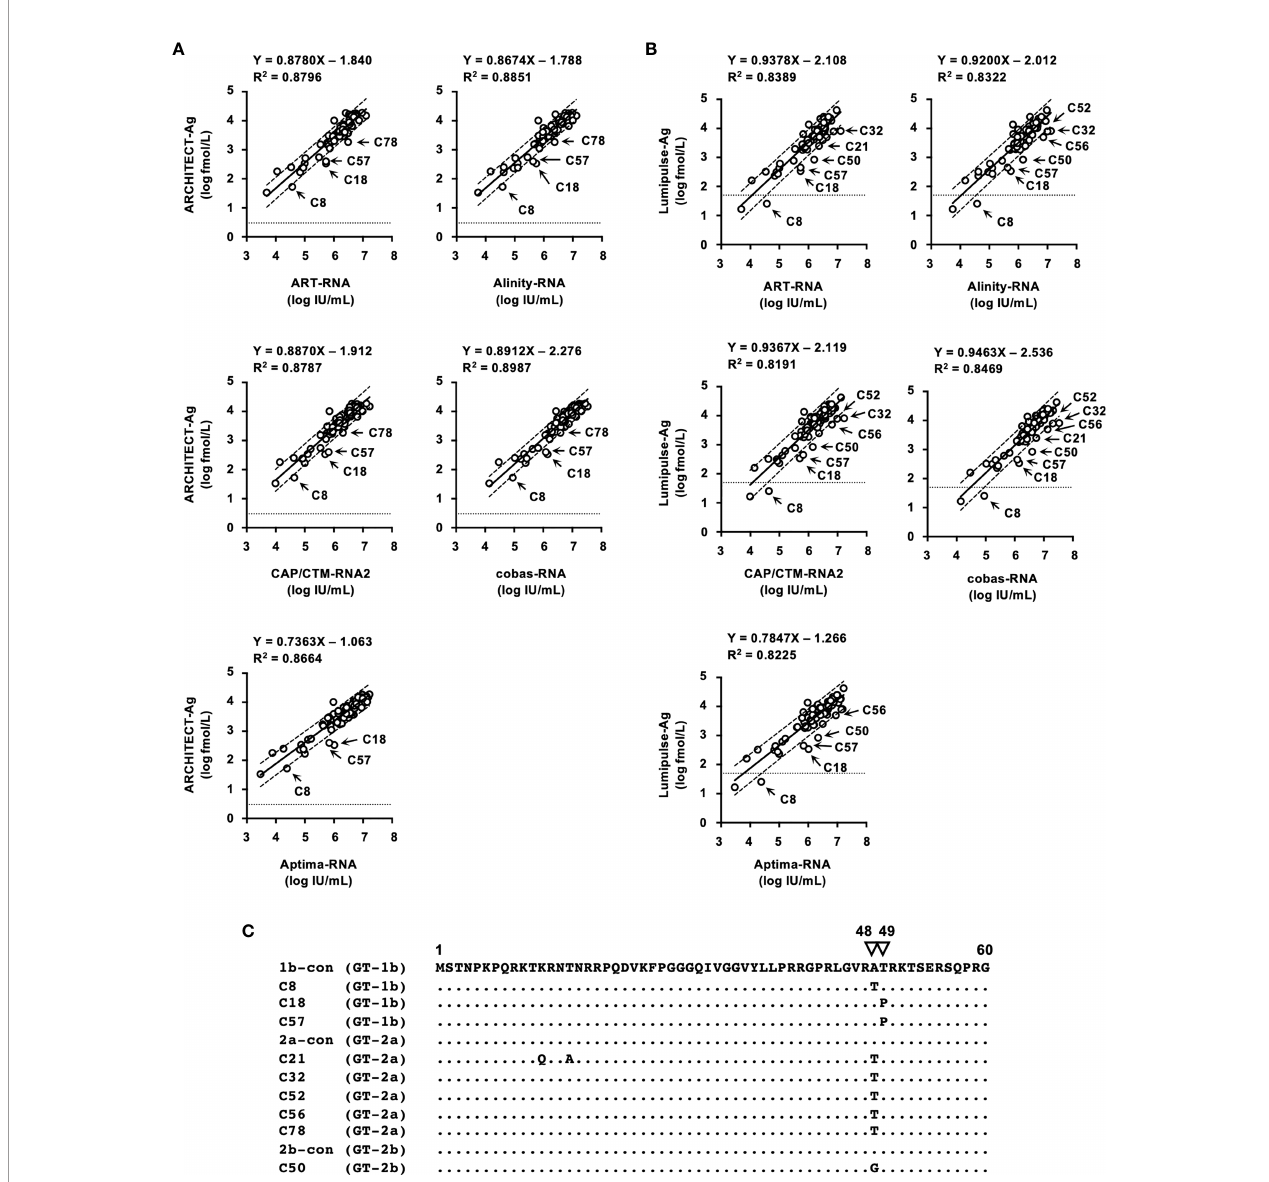
FIGURE 4 | Correlations between HCV RNA and HCV Ag quanti fi ed by ARCHITECT-Ag (A) and Lumipulse-Ag (B) . Data for HCV Ag levels were converted to log fmol/L prior to analysis. In each plot, the lower limit of quanti fi cation of the respective HCV Ag assay is indicated by a dotted line. Dashed lines indicate the 95% con fi dence intervals for the regression line. The correlation equation and the R 2 value are indicated at the top of the panel. (C) An alignment of the fi rst 60 amino acids of the HCV core region. Estimated amino acid sequences of nine strains with polymorphisms at amino acids 48 and 49 were aligned with the consensus sequence of each genotype: 1b-con, 2a-con, and 2b-con. Genotypes of aligned strains are indicated in parentheses. The position numbers are indicated at the top of the alignment, and amino acids at positions 48 and 49 are indicated by inverted triangles. Dots indicate identical amino